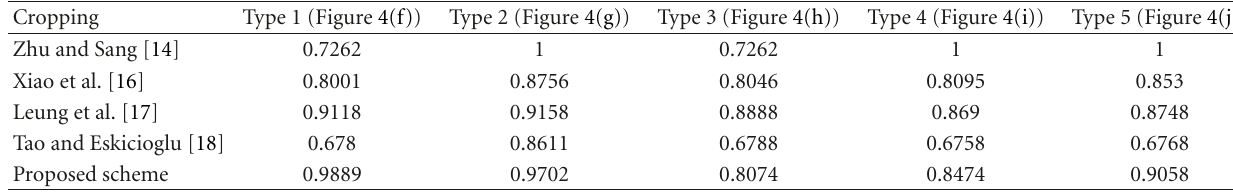
Table 7: Experiment results comparison under cropping (NC